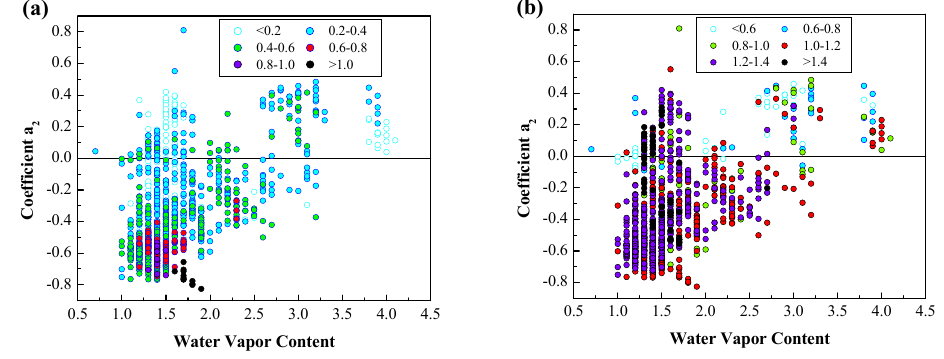
Fig. 13. Correlation between WVC and coefficient a 2 for various AOD 500 (a) and α 380 − 870 (b) intervals.